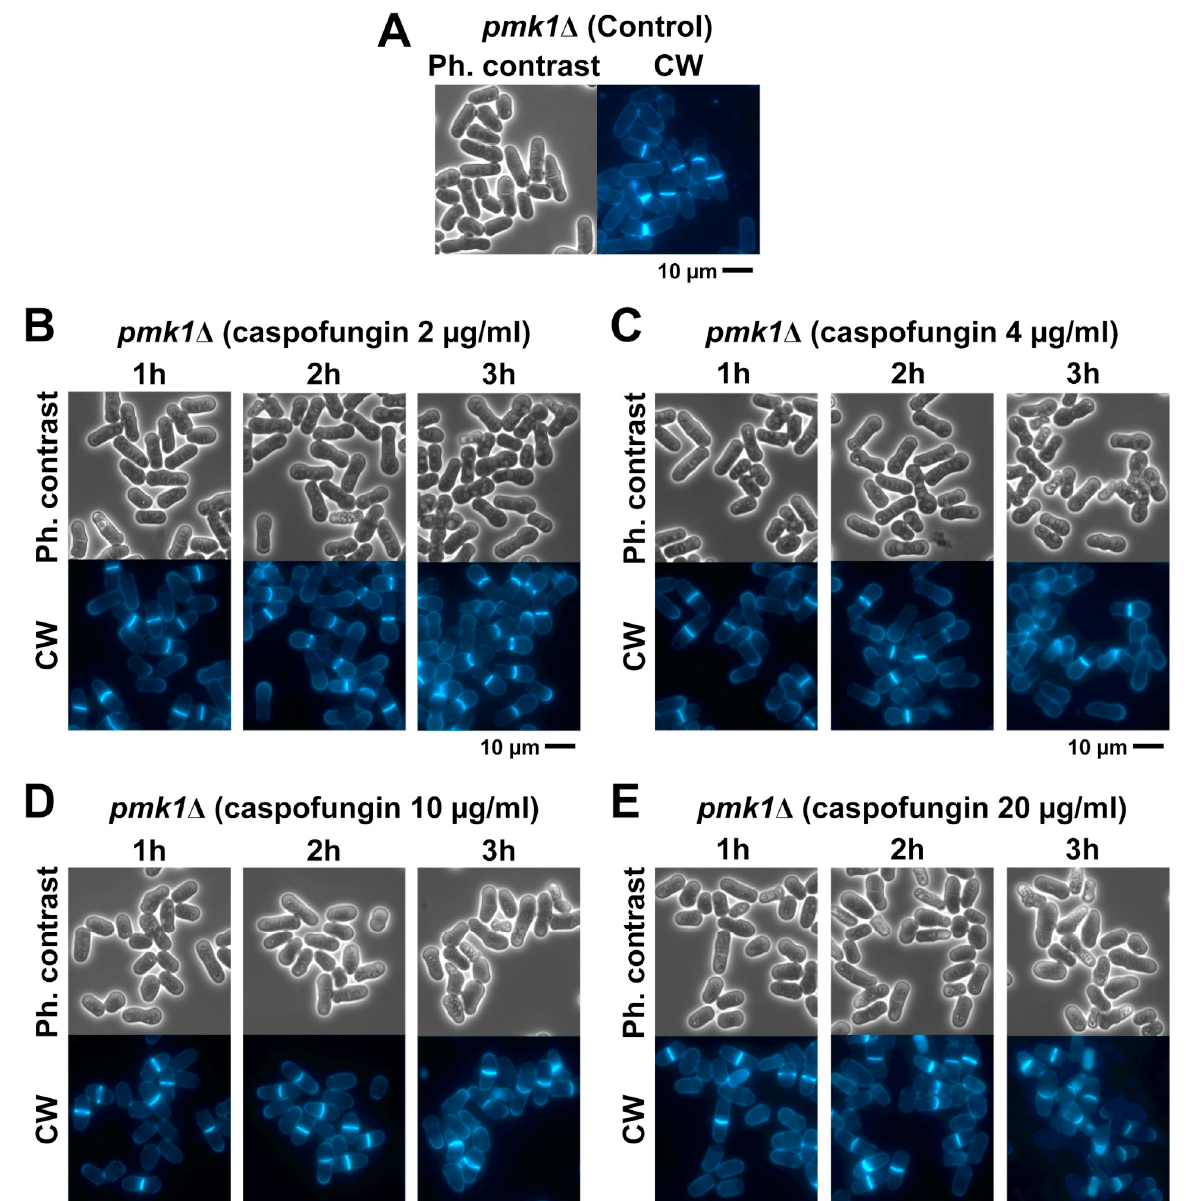
Figure 8. Cell morphology and septum formation of pmk1 ∆ cells growing in the presence of sublethal and lethal concentrations of caspofungin. Phase ‐ contrast and fluorescence micrographs of CW ‐ stained pmk1 ∆ cells. Cells were grown to early log phase at 28 °C in YES liquid medium and imaged at the indicated times using phase ‐ contrast and CW fluorescence microscopy either in the absence (( A ): control) or in the presence of sublethal (( B ): 2 μ g/mL; ( C ): 4 μ g/mL) or lethal (( D ): 10 μ g/mL; ( E ): 20 μ g/mL) doses of the antifungal. Scale bars: 10 μ m.